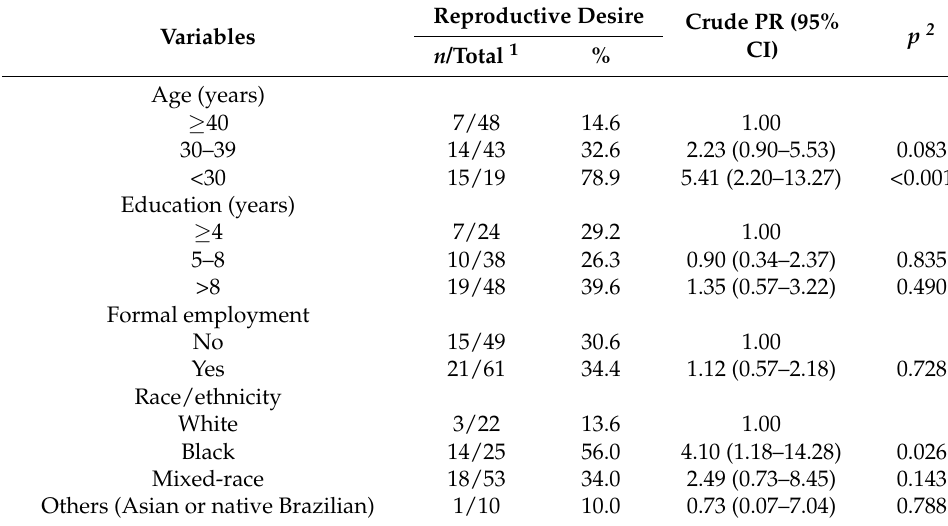
Table 2. Potential factors associated with reproductive desire in women living with HIV/AIDS with serodiscordant partners, Goi á s State,